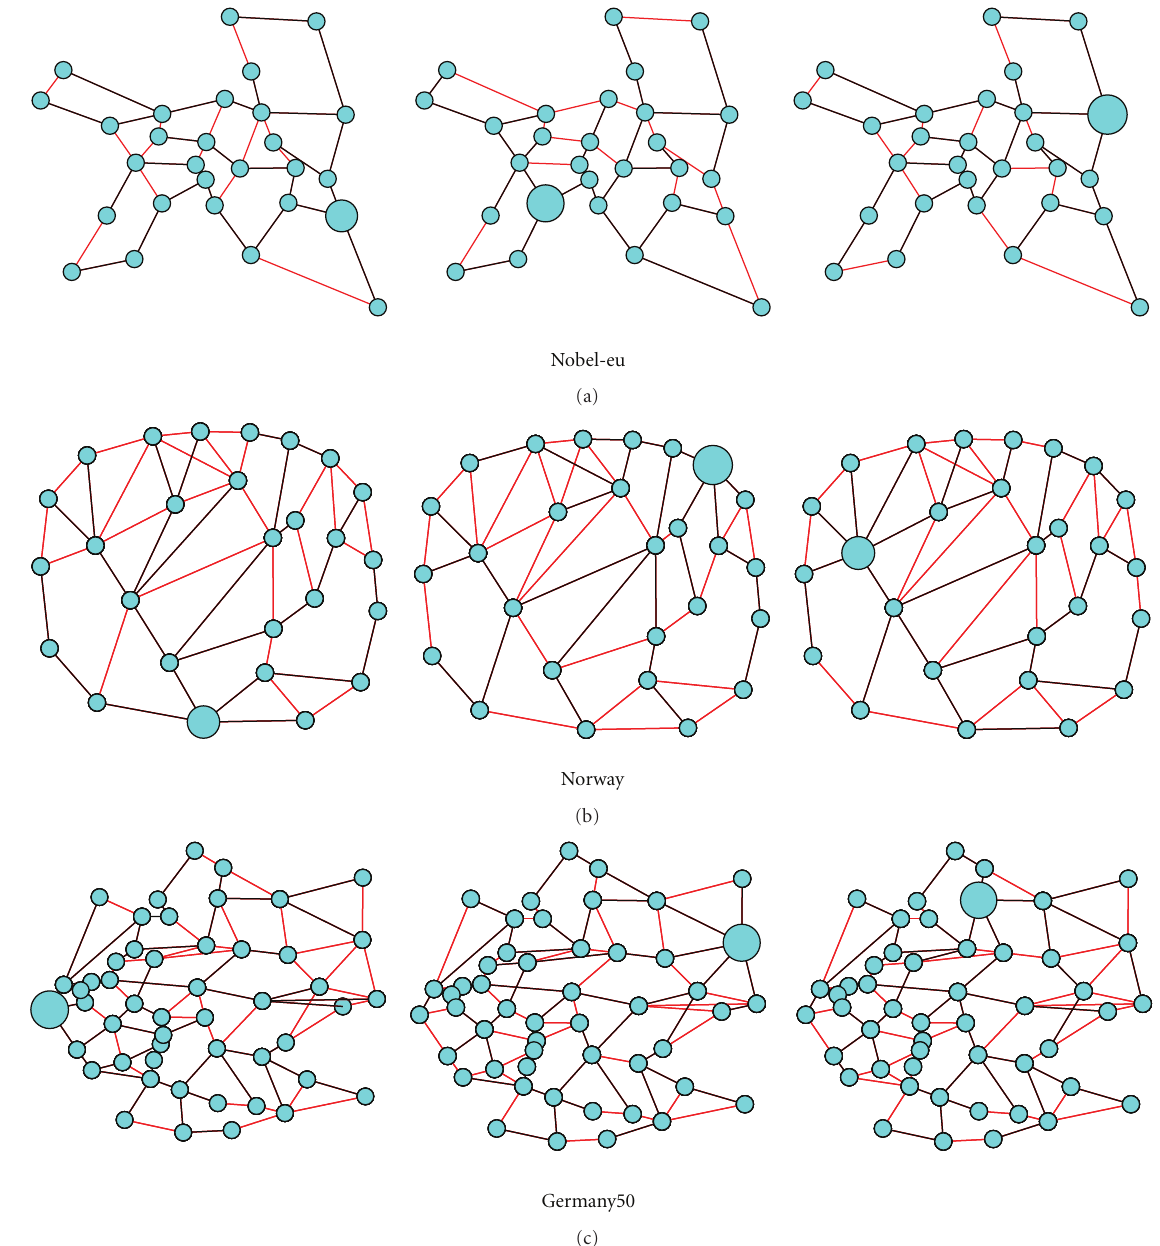
Figure 6: Three network topologies, each showing three typical multicast trees. Bold nodes are the roots of IPTV multicast trees.